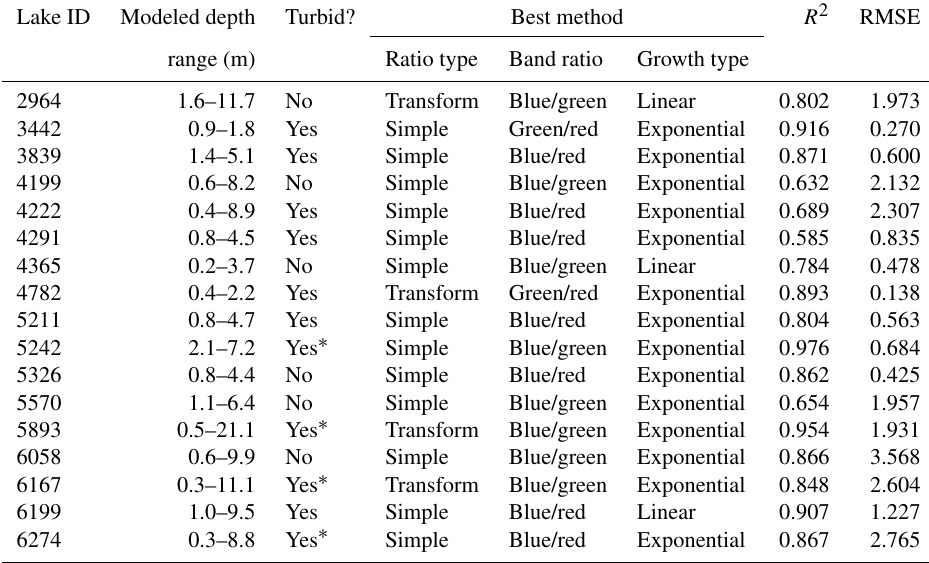
Table 3. The best spectral-depth model for each lake (based on R 2 ). A simple ratio exponential function provided the best model for the greatest number of lakes, while the blue/green and blue/red band ratios both provided good inputs for models at different lakes, accounting for the best spectral-depth models at eight and seven lakes, respectively. The average R 2 of the best model at each lake is 0.818 with an average root mean squared error (RMSE) of 1.439m.